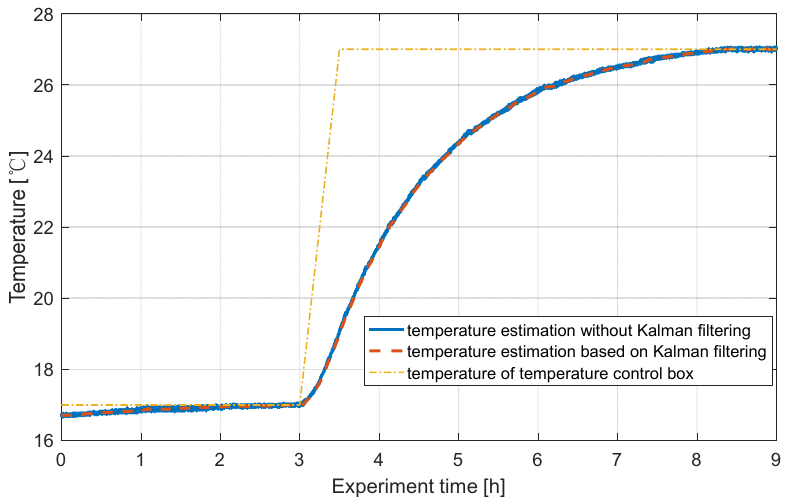
Figure 6. Temperature of the temperature control box and the estimated temperature of the link.